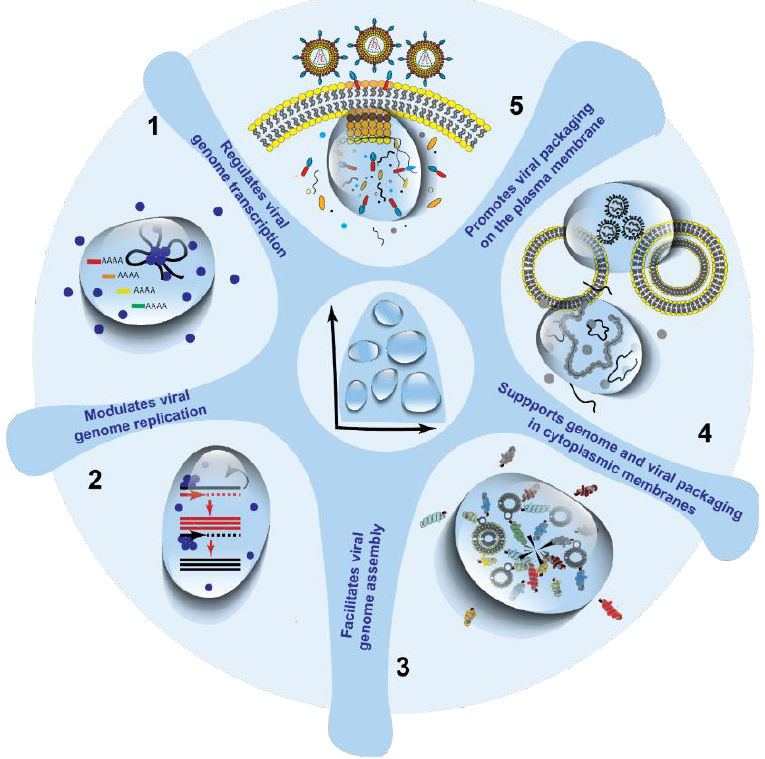
Figure 7. Liquid organelles can play different roles in viral infections. Despite being early days, liquid organelles have already been hypothesized to play many different functions in viral infec- tions.